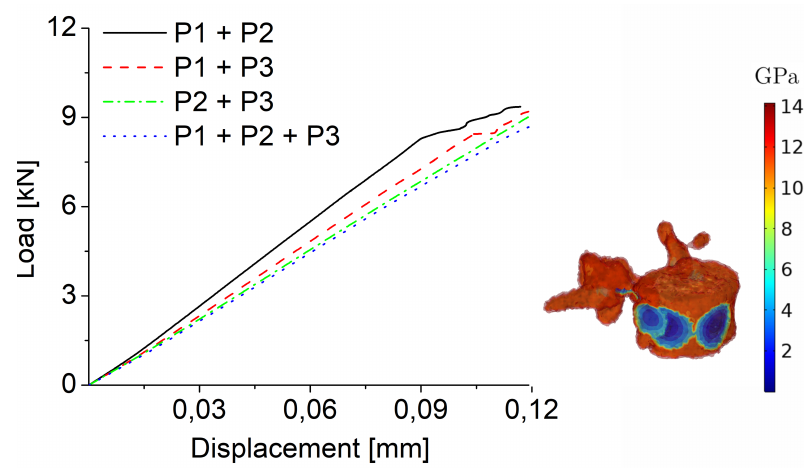
Figure 9. On the left, load-displacement curves obtained for multiple osteolytic lesions with a radius of 10 mm in bending loading mode using the strain-based failure criterion are reported. On the right, the distribution of Young’s modulus in case of multiple osteolytic lesions (P1+P2+P3) is